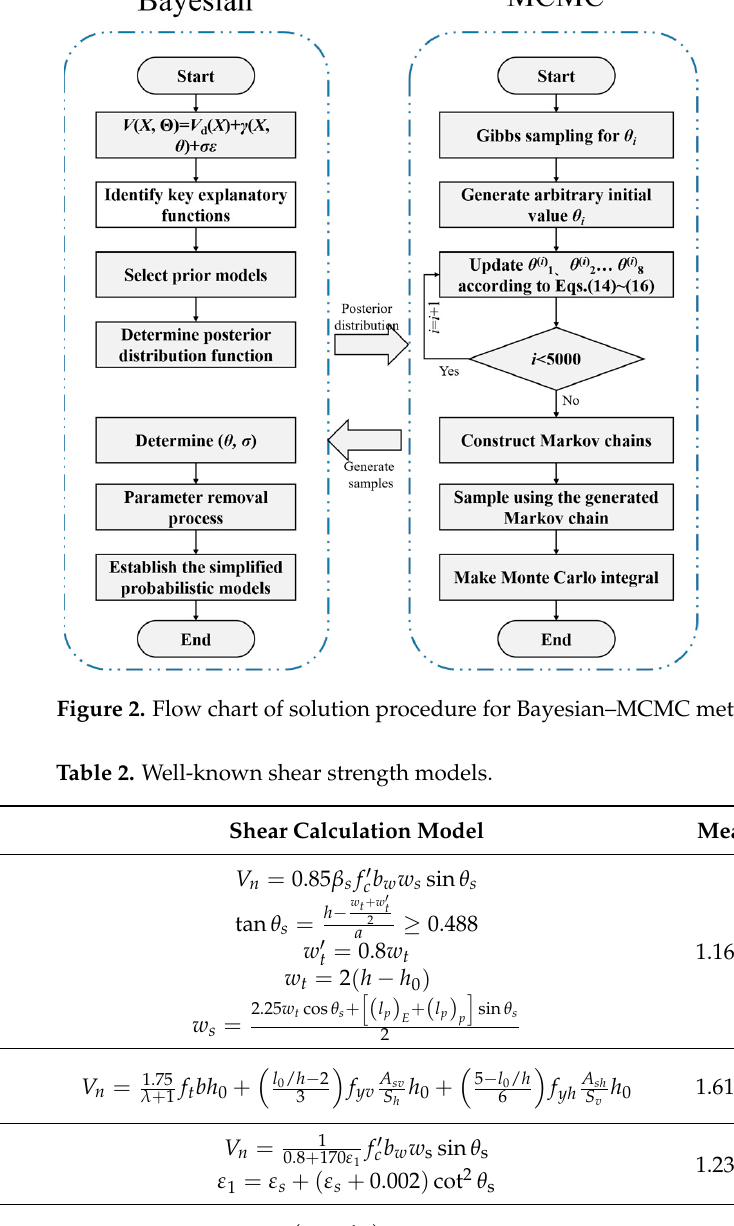
Table 2. Well-known shear strength models.